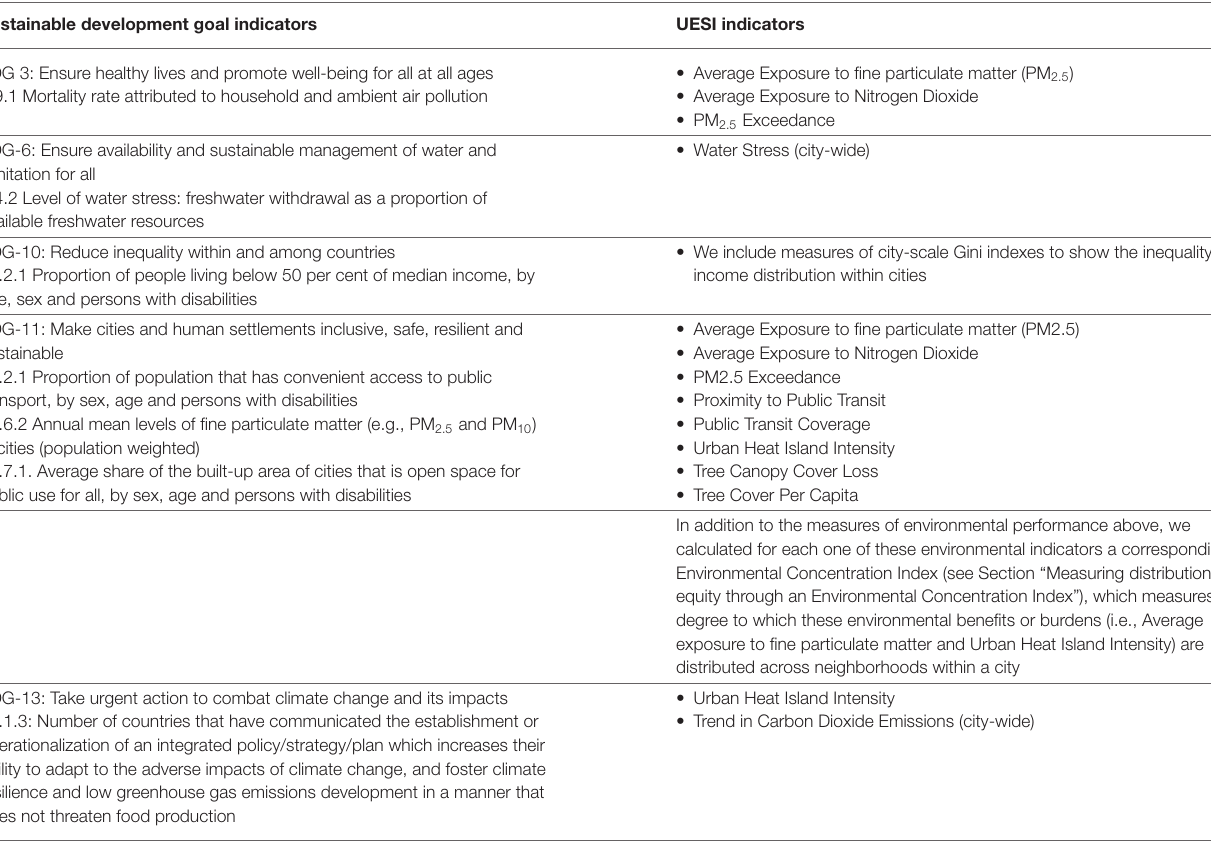
TABLE 1 | Mapping the UESI’s indicators according to related Sustainable Development Goal targets and indicators. Sustainable development goal indicators UESI